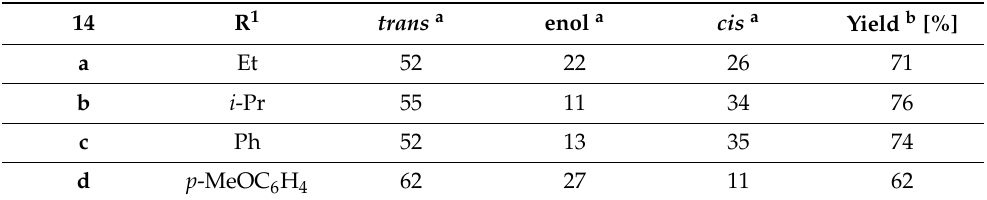
Table 5. Yields and isomer ratios of 2-substituted 3-diethoxyphosphoryltetrahydropyran-4-ones 14a-d